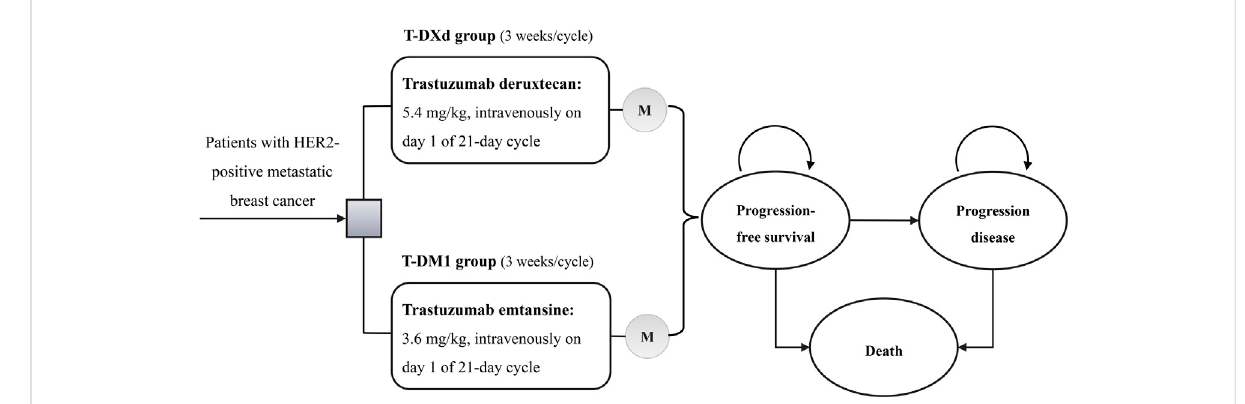
FIGURE 1 Markov model. T-DM1, trastuzumab emtansine; T-DXd, trastuzumab